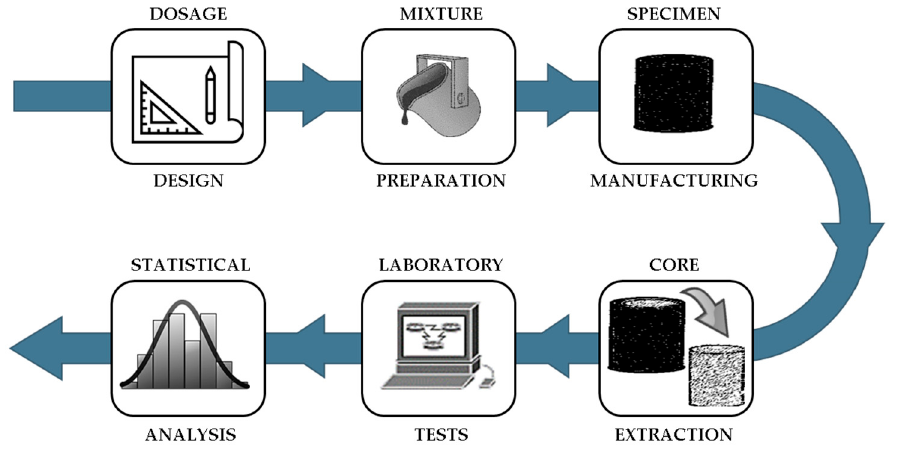
Figure 1. Graphical summary of the main steps forming the proposed methodology.